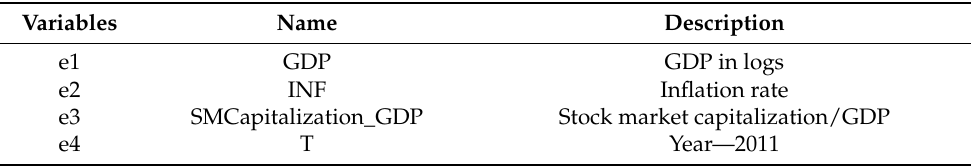
Table 3. Definition of environmental